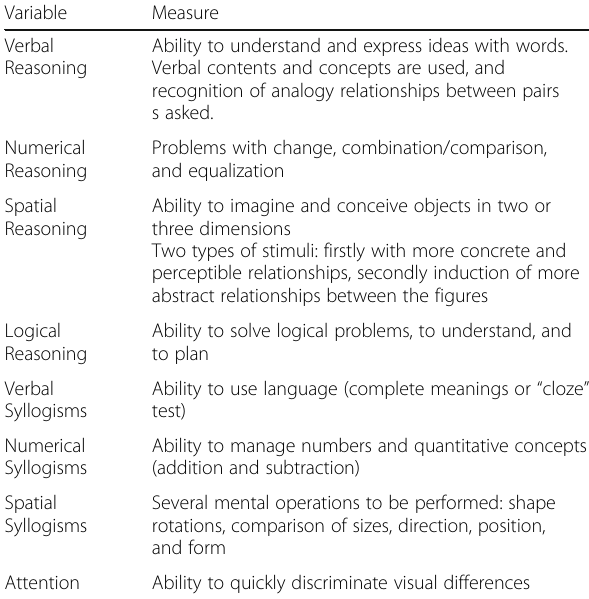
Table 2 BADyG-E2r scales